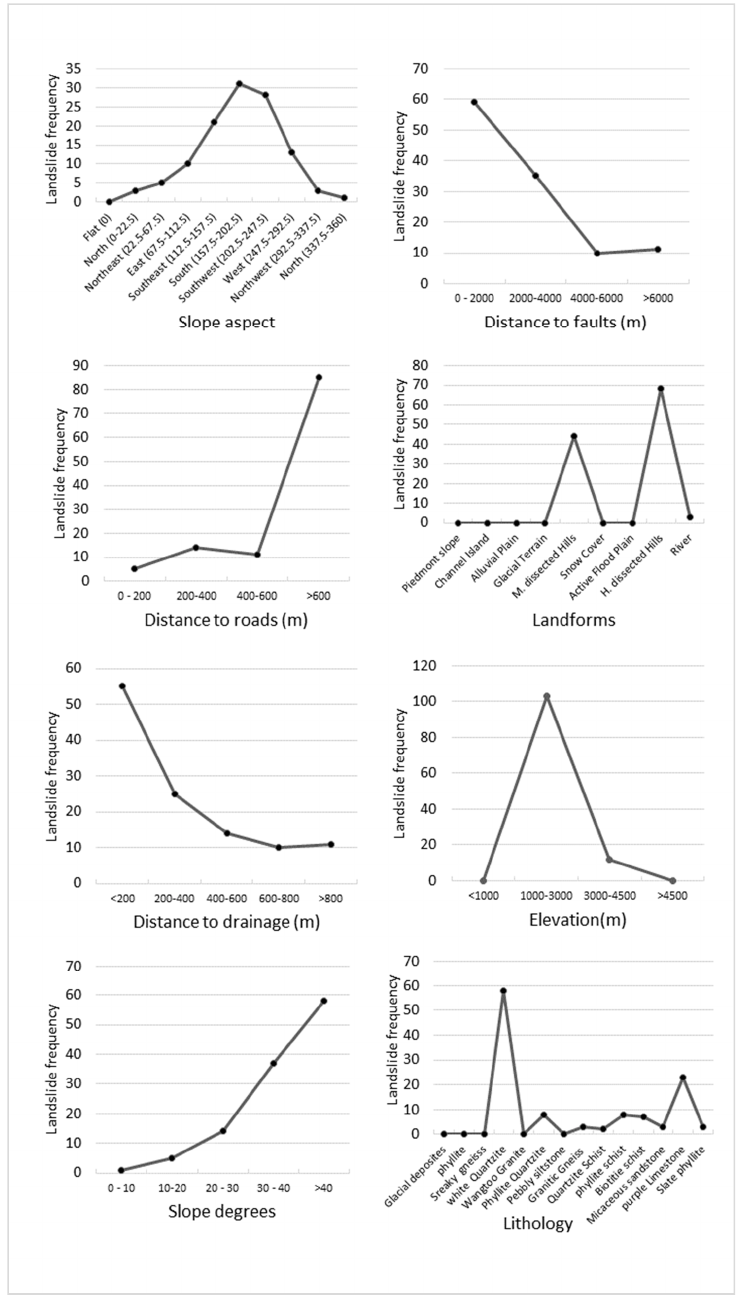
Figure 4. Shows the landslide distribution in each class of the eight conditioning